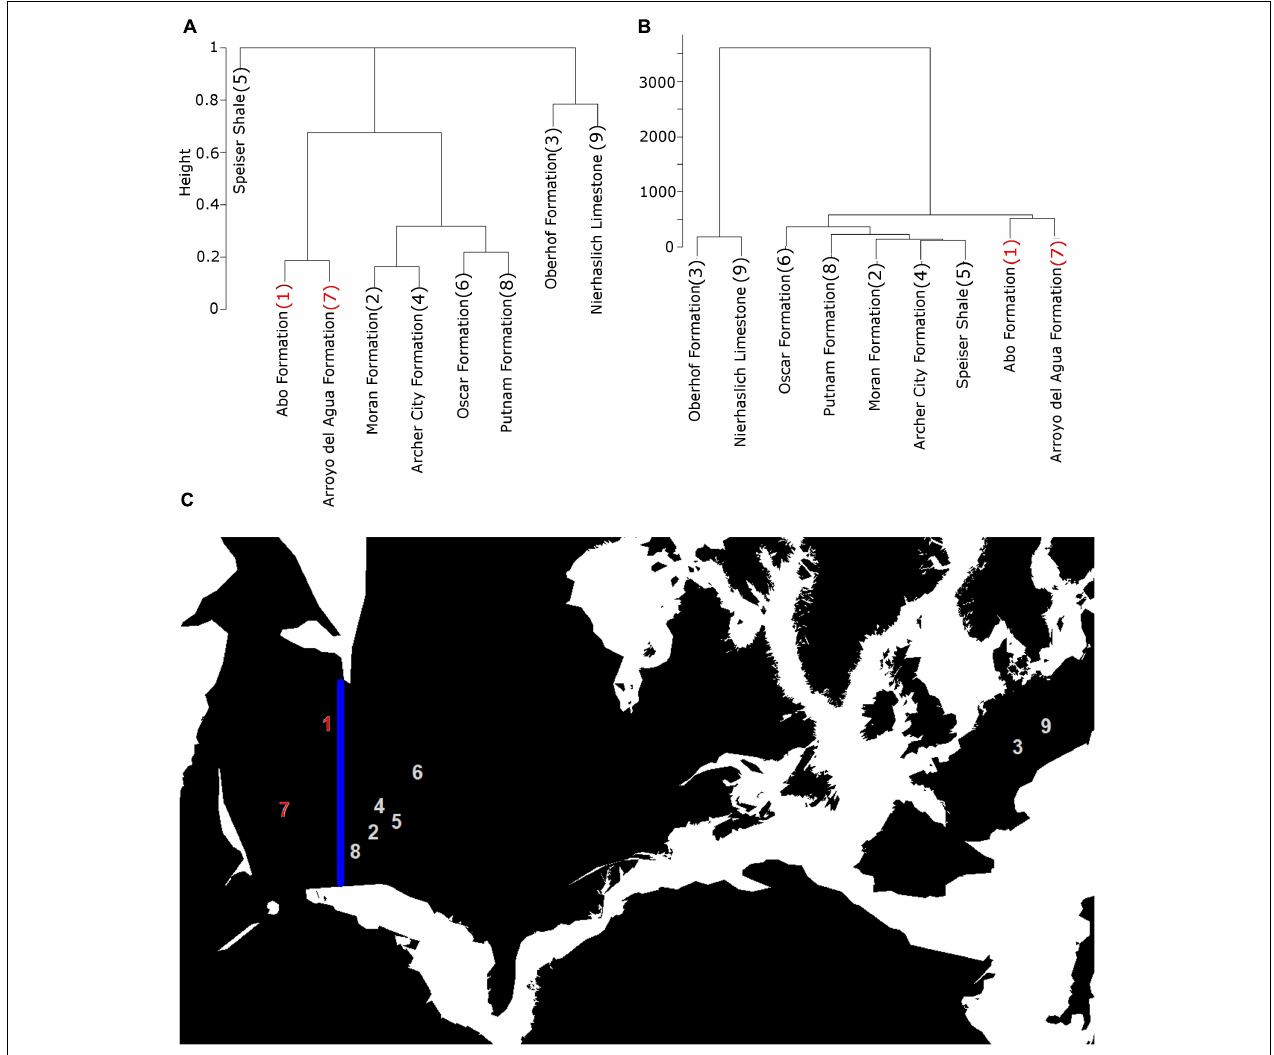
FIGURE 5 | Illustration of the early Sakmarian formations, showing the taxonomic and geographic clustering of the European formations and those in North America west of the Hueco Seaway (seaway not visible on this map). (A) Cluster dendrogram based of taxonomic distances; (B) Cluster dendrogram based on geographic distances; (C) Location of the formations. The blue line represents the division between those west and east of the Hueco Seaway. Numbers on cluster dendrogram labels correspond to labels on the map. Maps from the R package